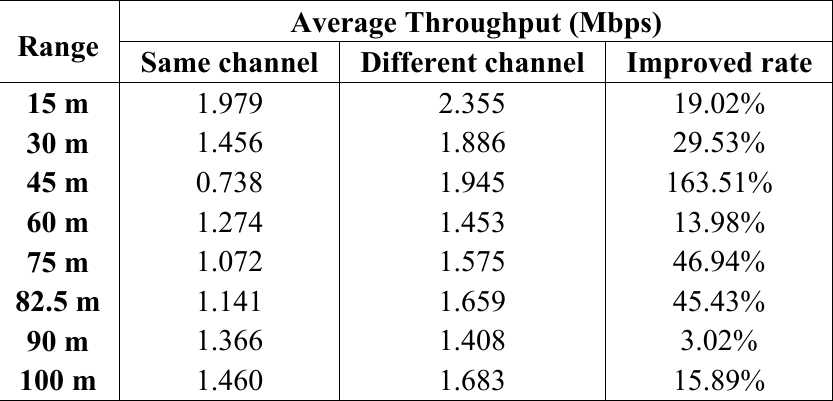
Table 5. A comparison between test 2 and test